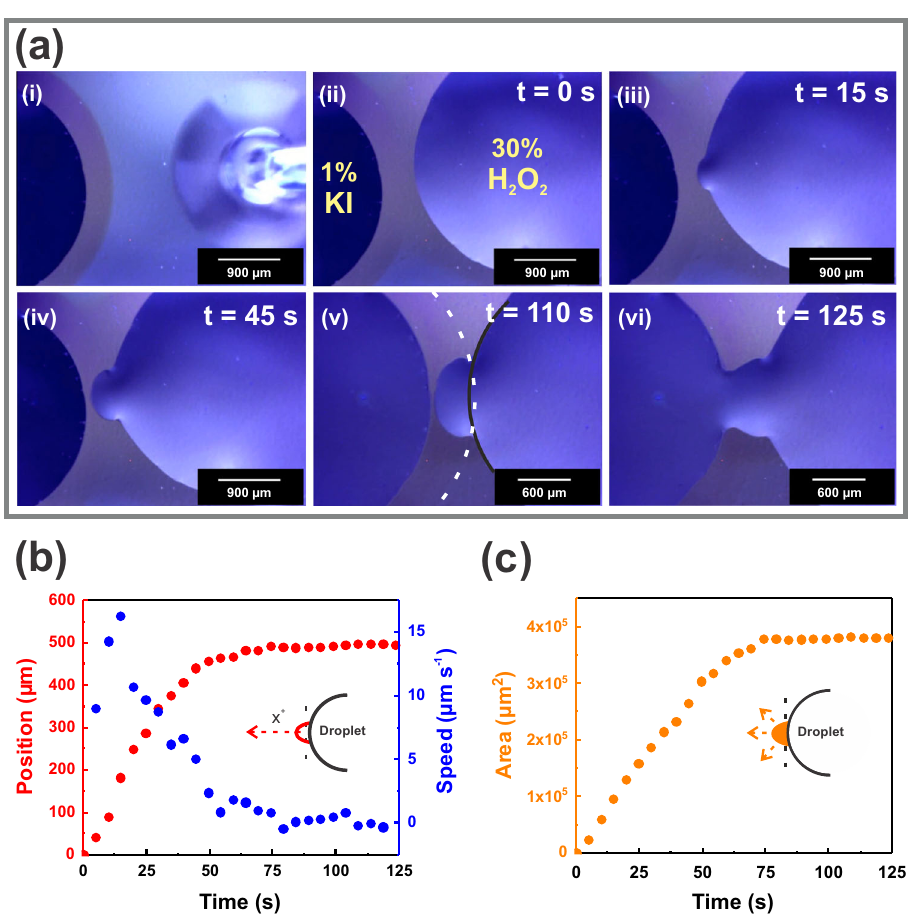
Fig. 3 Droplet bridging dynamics. a Snapshots to show views of the H 2 O 2 droplet autonomously projecting by interacting with the spatially separated KI droplet on a nanoporous thin fi lm surface (see also Supplementary Movie 1). After reaching maximum spreading and forming a circular shape, the H 2 O 2 droplet spontaneously deforms where it notices the fl uid released from the neighboring KI droplet across the nanopores (attractor annulus), followed by the projection in a protrusion morphology resembling a cell pseudopod. The protrusion then grows directionally towards the KI droplet; fi nally, coupling of the droplets occurs, forming a communicating bridge that allows the fast passage of material from one droplet to each other. The black and white superimposed curves in the fi fth panel (v) mark the extrapolation of the outlines of the H 2 O 2 droplet and the annulus surrounding the KI droplet, respectively. b Position and velocity of the tracking point of the protrusion at the leading edge as a function of time. c Temporal dependence of the expanding protrusion area. Protrusion decreased growth speed as it approached the KI droplet. Time interval between the dots in the curves is 5